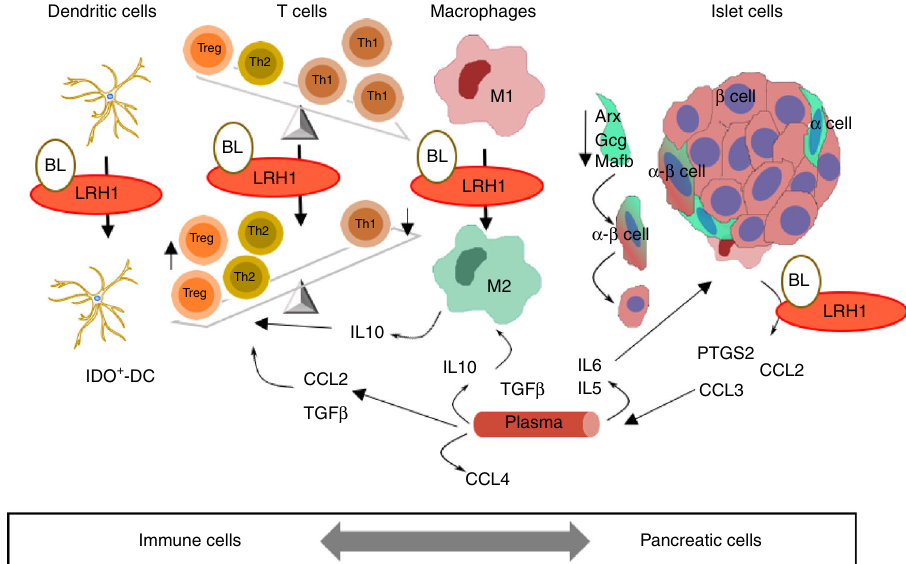
Fig. 8 Proposed model of BL001/LRH-1 cellular action. Schematic view of the effects of BL001 in changing the pancreas pro-in fl ammatory immune environment toward an anti-in fl ammatory environment, which promotes beta cell regeneration, possibly through alpha-to-beta cell